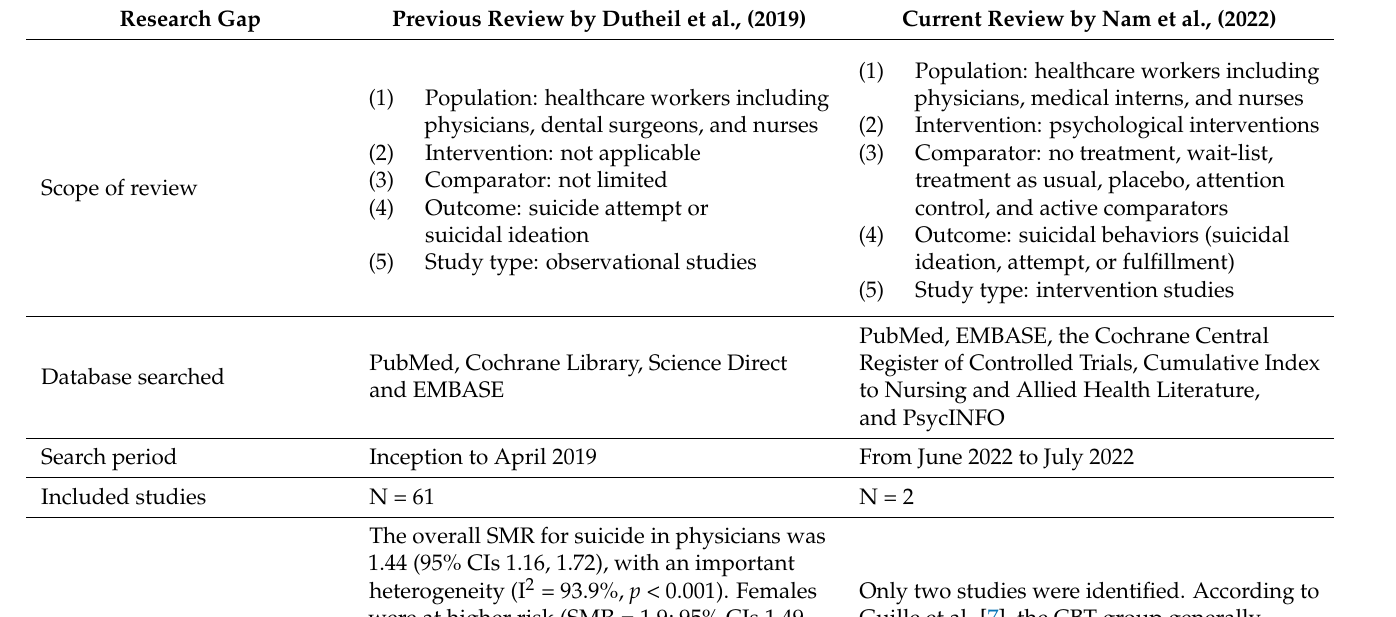
Table 3. Research gap in the suicide risk of healthcare